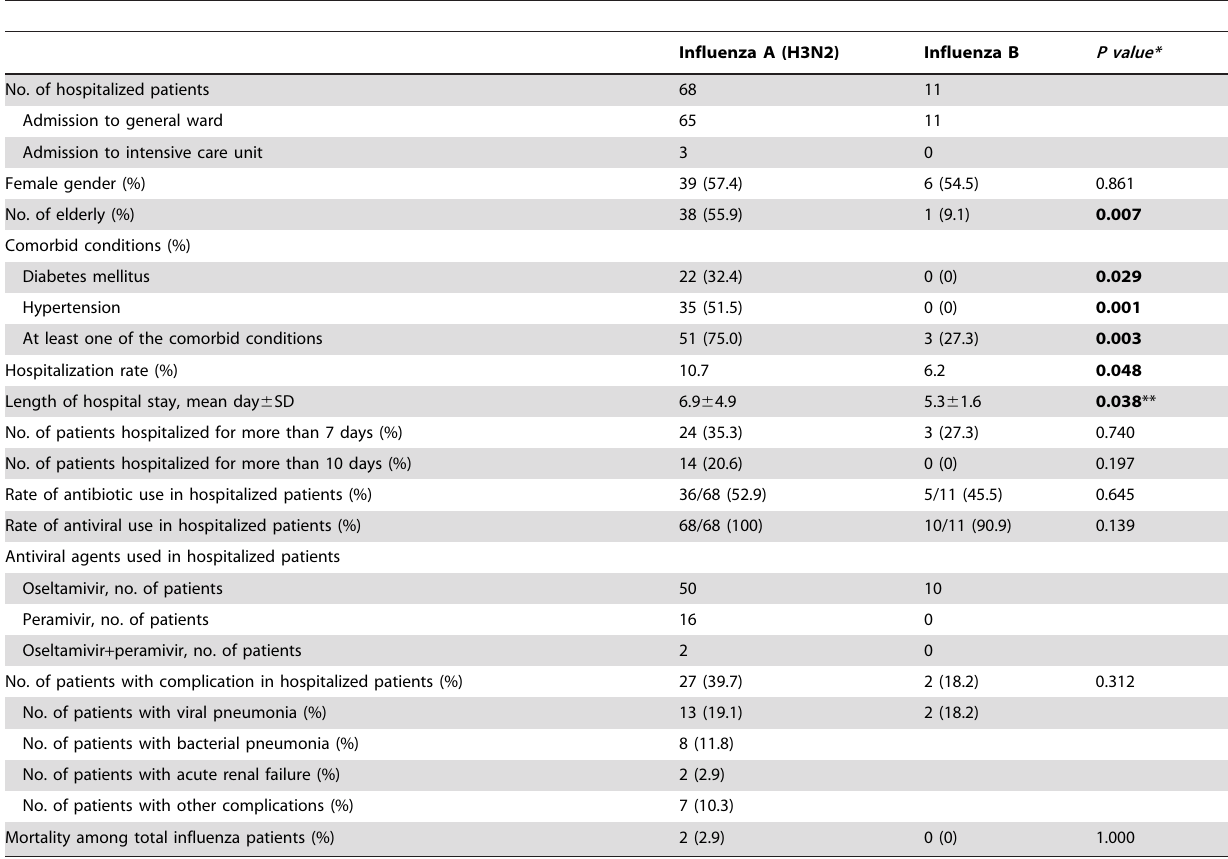
Table 4. Clinical outcomes of hospitalized patients with laboratory-confirmed Influenza A (H3N2) and Influenza B from October 2011 to May